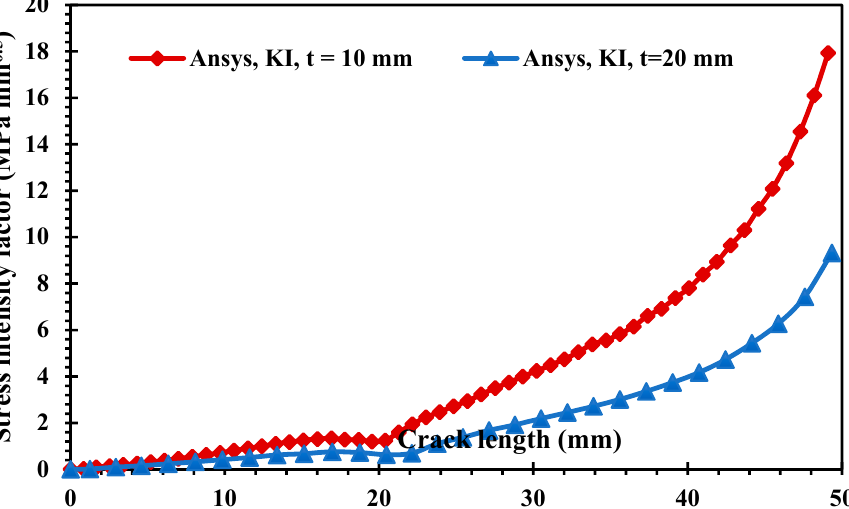
Figure 8. Results of the first mode of the stress intensity factor for different thicknesses.